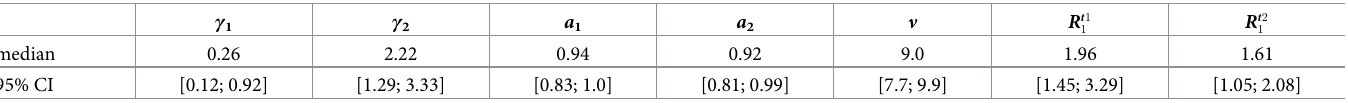
Table 1. Table of inferred posterior distributions of parameters of the model. Median values and 95% confidence interval of inferred posterior distributions of parame- ters of the model using the ABC approach.